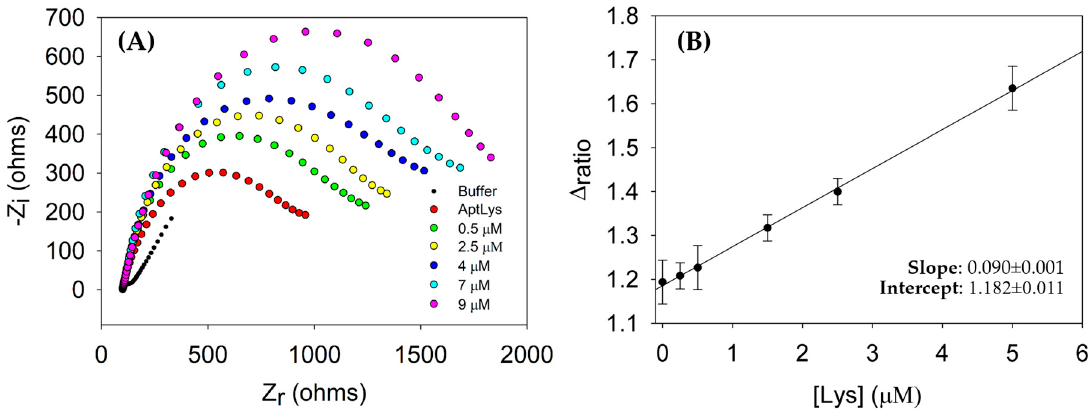
Figure 6. ( A ) Nyquist Plot for a biosensing protocol with increasing Lys concentrations: 0.5, 2.5, 4, 7 and 9 µM, ( B ) Calibration curve vs. Lys concentrations: 0, 0.25, 0.5, 1.5, 2.5 and 5 µM. Uncertainty values corresponding to replicated experiments ( n = 5). All the measurements were performed in PBS solution in the presence of the redox probe.